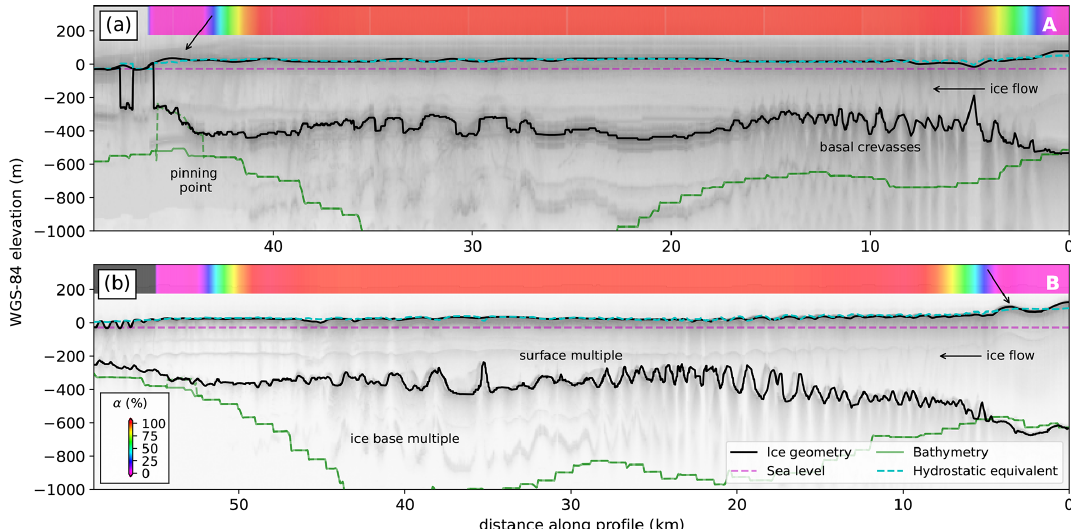
Figure 2. Radargrams from airborne radar surveys (a) in November 2009 and (b) in January 2019 revealing a heavily crevassed ice-base topography. Transects from the grounded ice (right), across the tidal-flexure zone as predicted by an elastic model based on the 2011 grounding line (Rignot et al., 2016) onto large parts of the freely floating ice shelf and (left) ultimately crossing the pinning point that is buttressing the Eastern Ice Shelf. Colors show the percentage tidal displacement with red areas experiencing the full range of the tidal oscillation, while the remaining areas are subject to tidal ice-shelf flexure. Purple areas are grounded according to the 2011 grounding line for the pinning point and the 2017 main grounding line of Thwaites Glacier. The dashed blue line shows flotation height. Grounded areas with surface elevation above flotation height are indicated by black